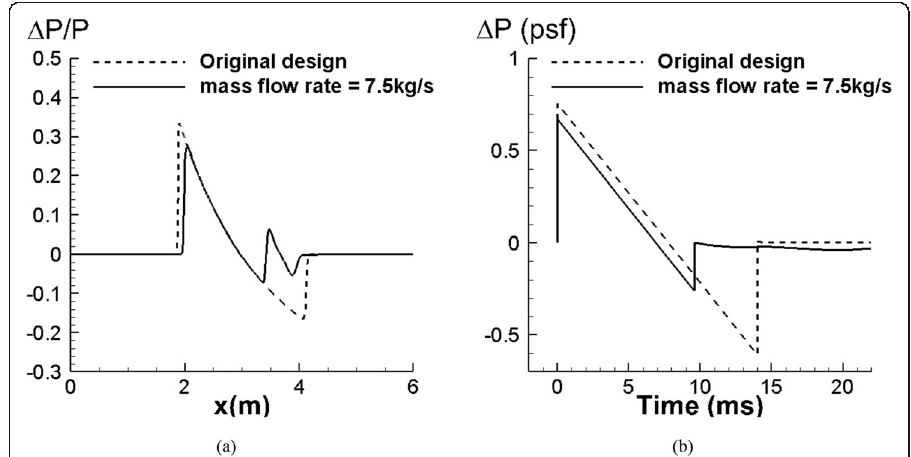
Fig. 15 The near-field signatures and corresponding ground signatures for the baseline and optimized NACA0008 airfoil at the mass flow rate = 7.5 kg/s. a comparison of the near-field signature b comparison of the ground boom